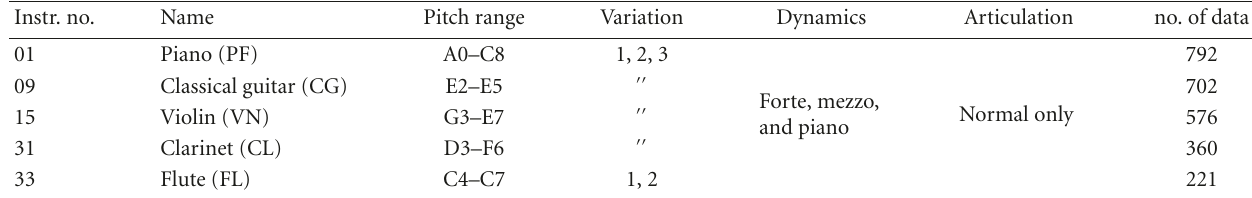
Table 3: Audio data on solo instruments.